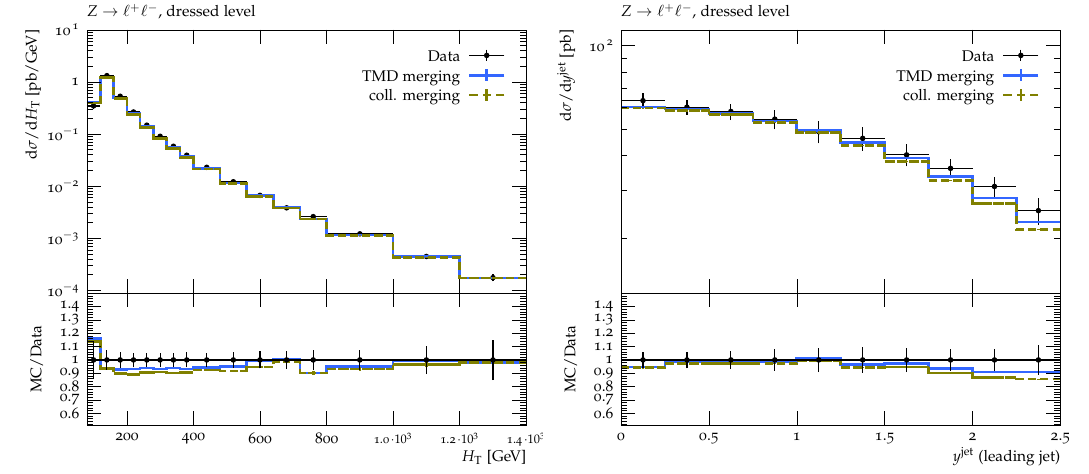
Figure 27 . Predictions obtained using Madgraph + Pythia 6 with MLM merging and the TMD merging framework are compared for the scalar sum H jets (left), and leading jet rapidity (right) distributions in Z + jets events. The phase space for the calculation follows the one in